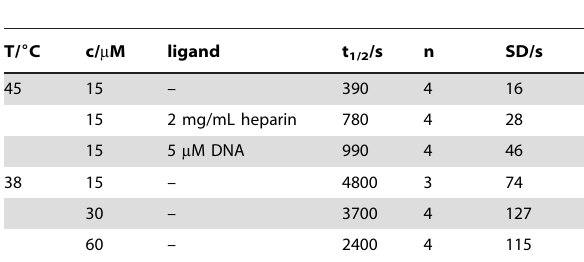
Table 2. Kinetic stability of QM-Hsp53. Effect of ligands and protein